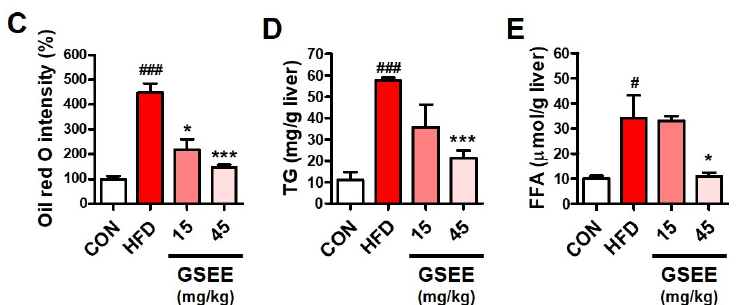
Figure 5. Inhibitory effects of GSEE on HFD-induced hepatic steatosis in mice: ( A ) liver tissues; ( B ) microscopic images of hematoxylin & eosin (H&E)- and oil red O-stained liver tissues; ( C ) relative oil red O intensity; ( D ) hepatic triglyceride (TG) levels; ( E ) hepatic free fatty acid (FFA) levels. Mice ( n = 8 in each group) were fed with HFD for 10 weeks with or without daily oral administration of GSEE (15 or 45 mg/kg of body weight). Relative oil red O intensity was measured using microscopic images of liver tissues from randomly selected 3 mice in each group. Values are represented as mean ± SE.